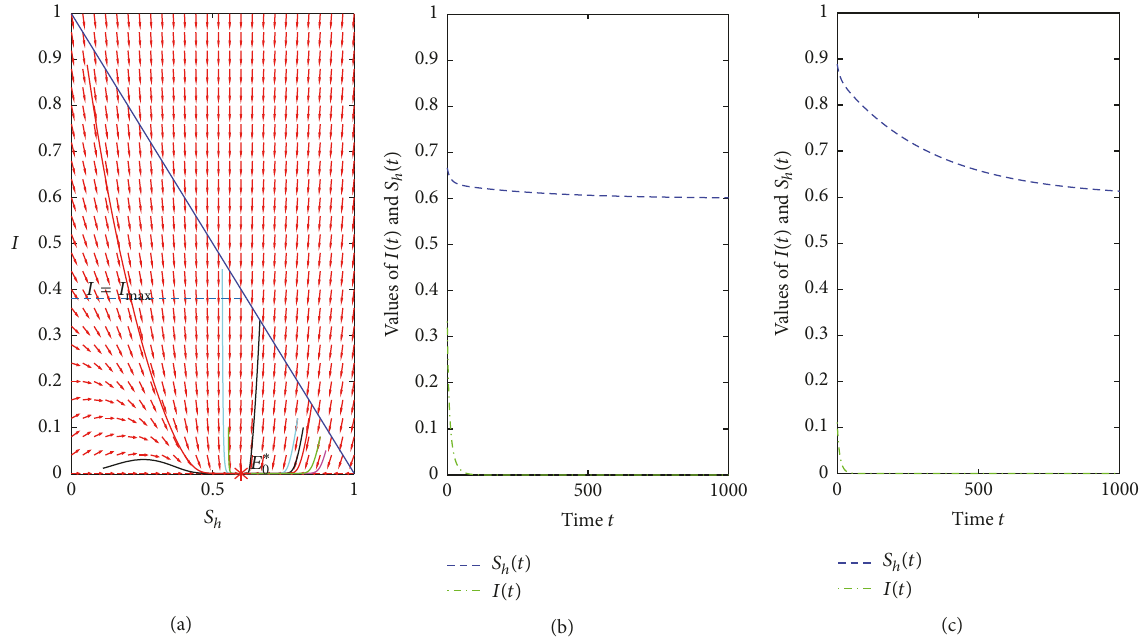
Figure 5: Trajectory figure and time plots of Example 3.